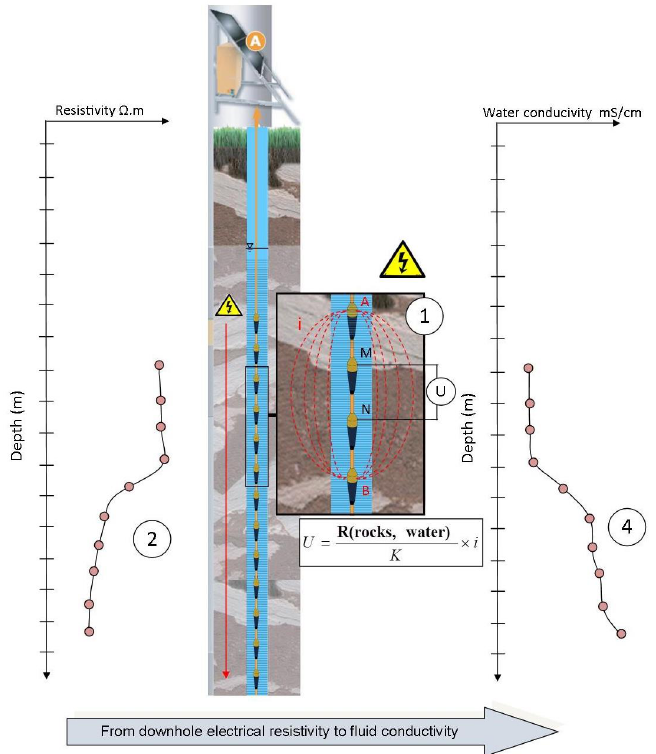
Figure 3. Schematic of the subsurface monitoring device (SMD). An automatic, remote-controlled geophysical tool, which allows the measurement of water electrical conductivity profiles in high spatial and temporal resolution. The SMD includes a cable loaded with electrodes, which provide a profile of the resistivity of the rock formation around the borehole. (1) Current (i) between two electrodes (A and B) measure the induced potential difference between two other electrodes (M and N). According to Ohm’s law corrected by a geometric factor, bulk resistivity (R) is thus obtained (U = R (formation, pore) * (i)/k. U is the tension (Volt) and K the formation factor (2) This process is repeated from the top of the electrodes cable to its bottom allowing the measurement of bulk resistivity profiles. (3) According to the Waxman–Smits equation, bulk resistivity is converted in to ECw20. This conversion needs to know the formation factor (F), and the surface conductivity term ( Cs ), which are determined using a reduced set of logging measurement (gamma ray, resistivity and sonic for porosity). (4) Finally ECw20 profiles are obtained. The ECw20 profiles are corrected from borehole e ff ect and normalized in